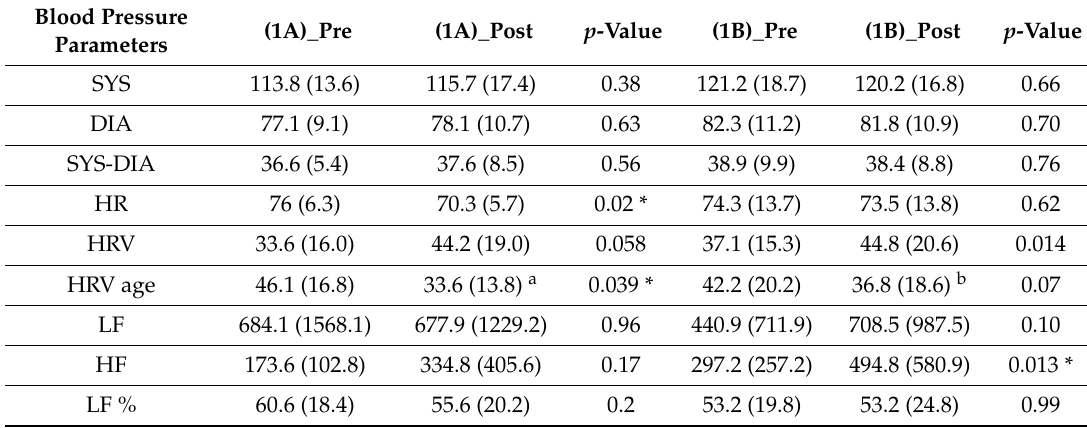
Table 4. Blood pressure waves obtained from experiment 1.